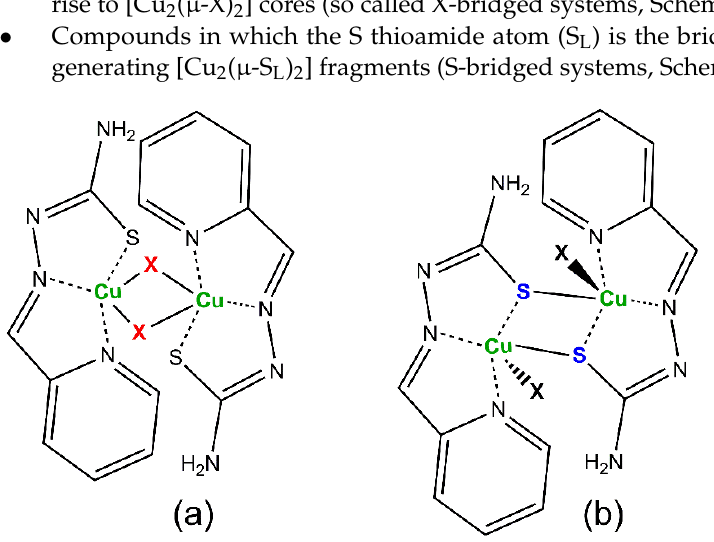
Scheme 4. Usual structures for [{CuLX} 2 ] compounds: ( a ) X-bridged, ( b ) S-bridged